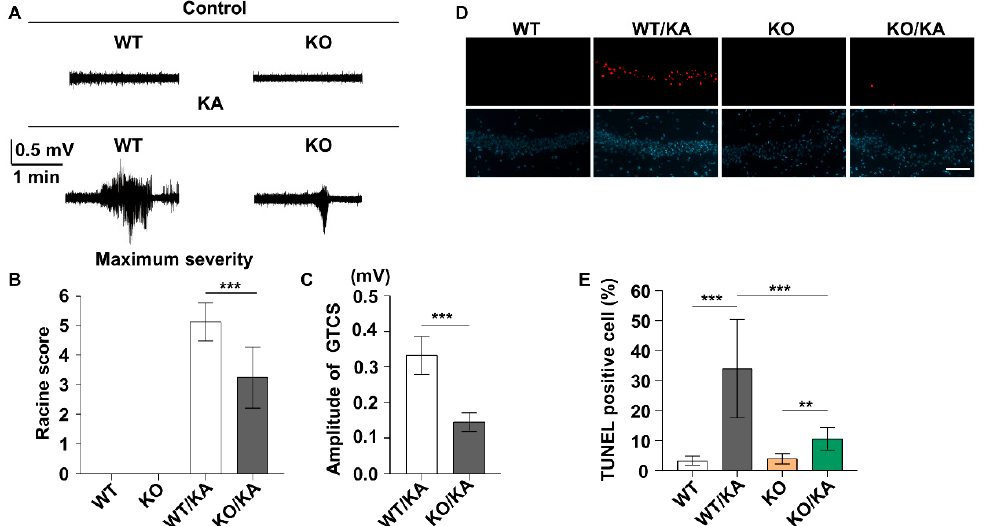
Figure 4. DAPK1 KO attenuates seizure severity and neuronal apoptosis induced by KA. The elec- trodes were implanted into mice (C57BL/6, male/female, 8–12 weeks, n = 8/group), which were allowed to recover for 7 days. WT and DAPK1 KO mice were treated with the same dose of KA. ( A ) Representative EEG recordings from 0.9% saline- and KA-treated mice are shown for WT and DAPK1 KO mice. ( B , C ) DAPK1 ablation in mice led to reduced seizure scales ( B ) and GTCS ampli- tudes ( C ) after KA insult compared with their age-matched WT littermates (** p < 0.01, *** p < 0.001, Student’s t -test). ( D ) Representative images showing TUNEL and Hoechst 33,342 staining in the hippocampus in the WT or KO group 72 h after KA treatment. ( E ) Statistical analysis of the TUNEL assay results (** p < 0.01, *** p < 0.001, one-way ANOVA with Tukey’s multiple comparisons test). Scale bar, 100 µ m. All the values were combined and are expressed as the mean ± SD. Experiments were performed in triplicate with at least two mice per group per experiment.